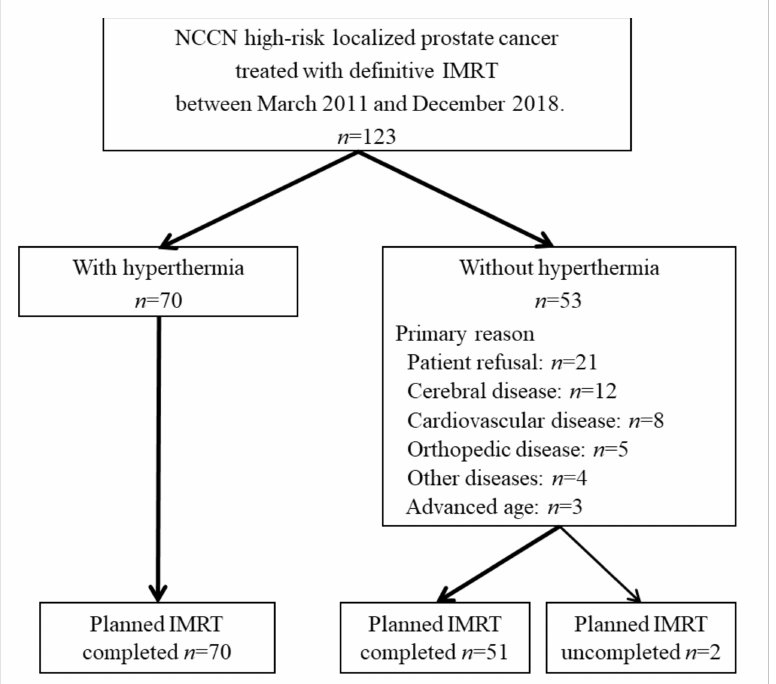
Figure 1. Patient flow diagram.